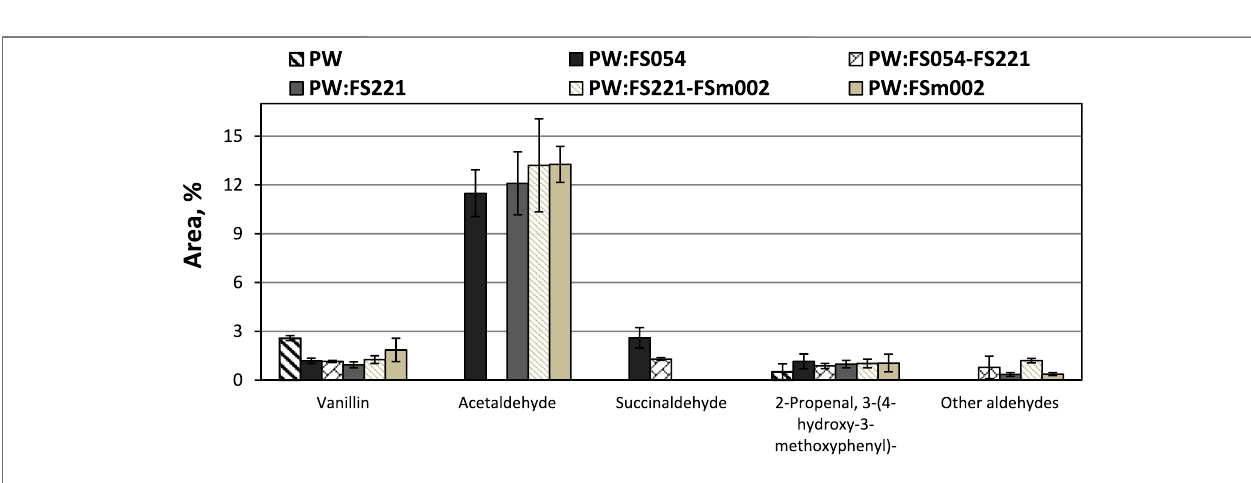
Frontiers in Energy Research |